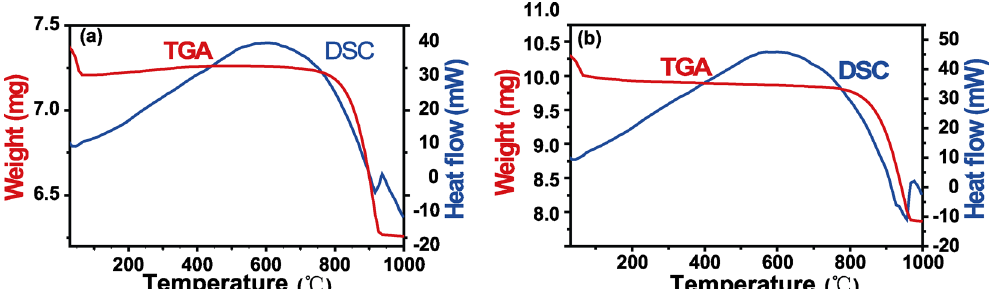
Fig. 1 TGA–DSC curves of stoichiometric mixture of raw materials (SrCO 3 and CeO 2 ) for (a) SrCeO 3 and (b) Sr 2 CeO 4